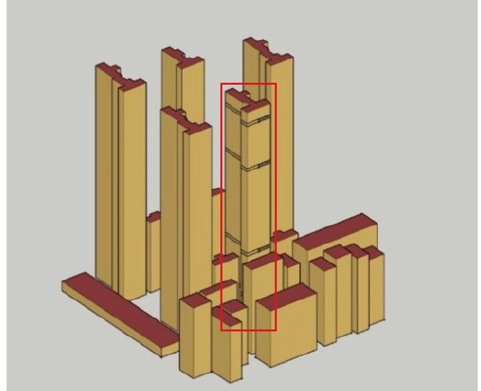
Figure 3. Building selected for the simulation.